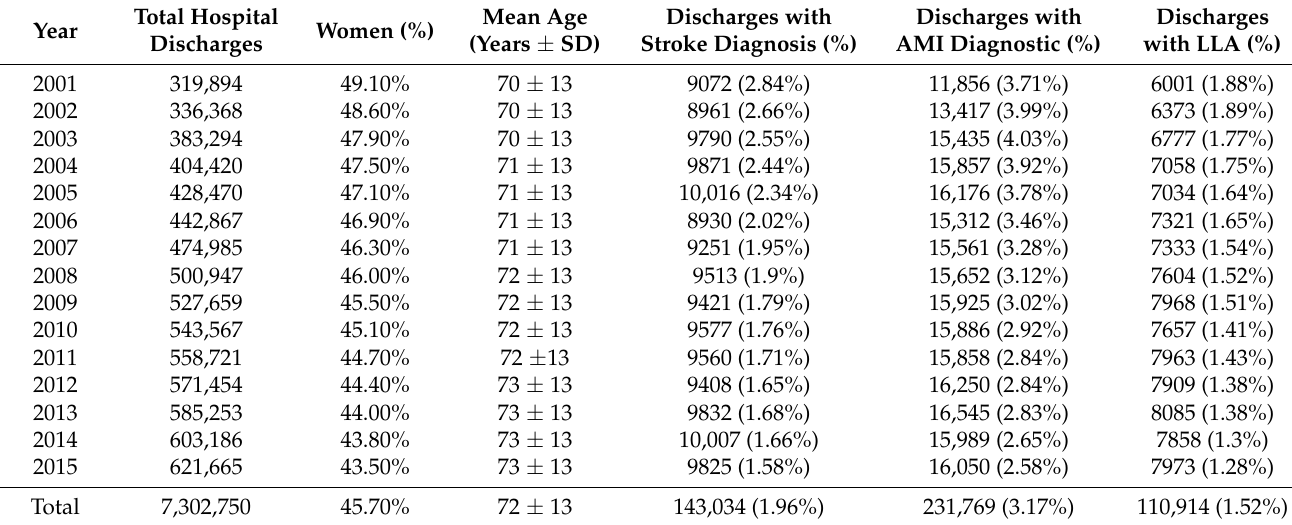
Table 1. Distribution of the number of hospital discharges with a primary or secondary diagnosis of DM for each year of study. Count and relative percentage of cardiovascular complications in each year of the study with respect to the total